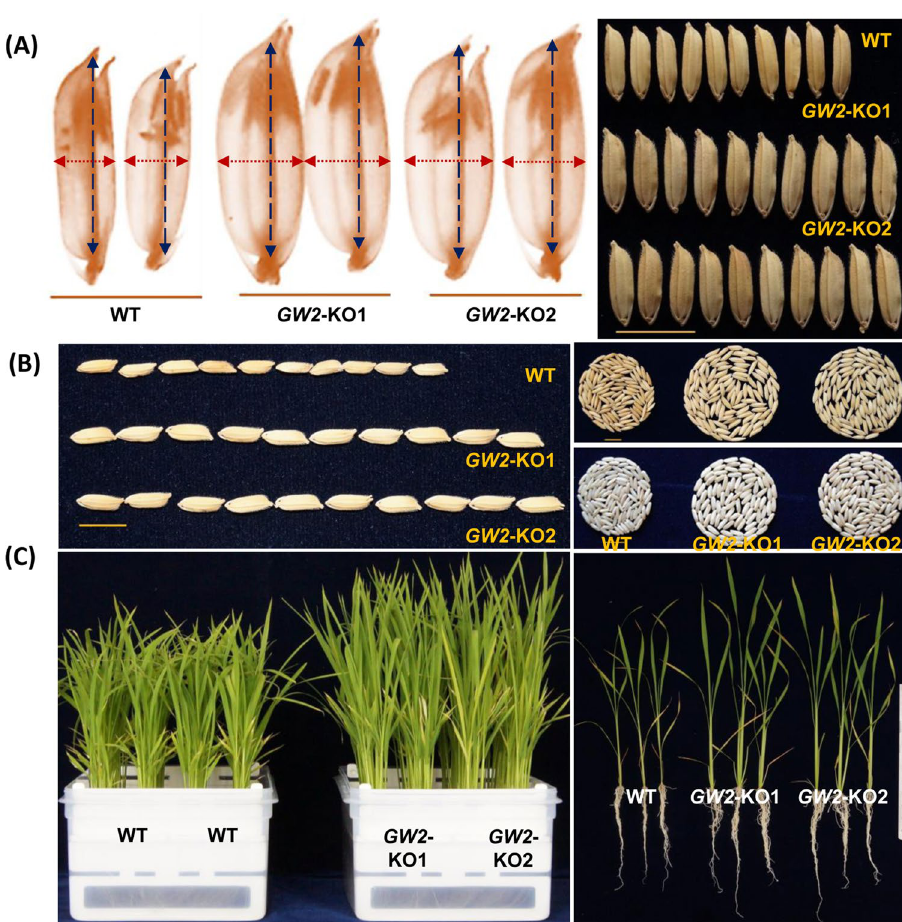
Figure 4. Grain phenotype and agronomic performance of OsGW2 . GW2 -KO mutant lines showed improved hull morphology and seed architecture and grain width compared to WT plant ( A ). ( B ) The GW2 -KO lines exhibited increased seed length and 100 grain volume corresponding to WT line. ( C ) Phenotyping of 30-day old GW2 -KO lines showing improved root-shoot length and biomass corresponding to WT plant.